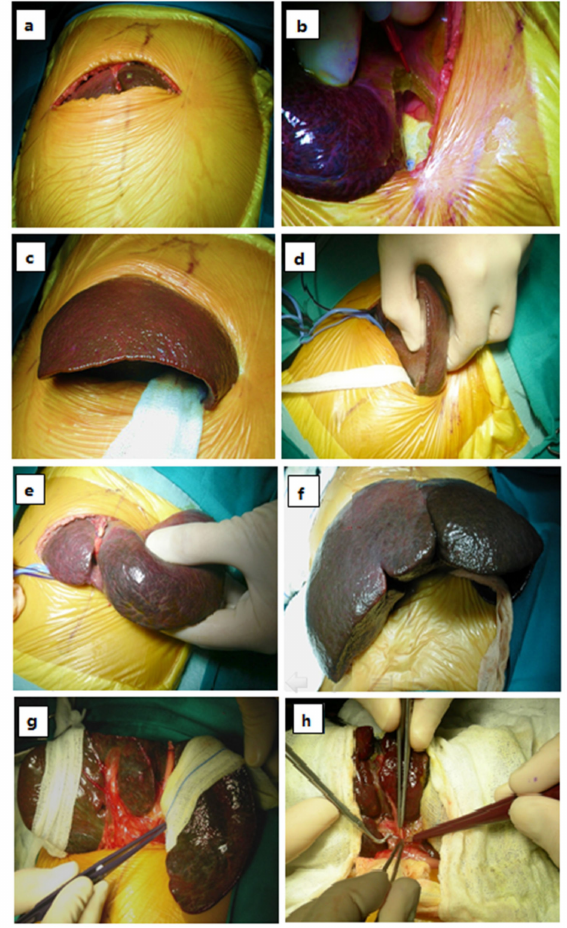
Figure 1. Laparotomy and ligation and division of the round ligament of the liver ( a ). Insertion of gauze between the left triangular and left coronary ligaments and the stomach and spleen. ( b ) The left lobe is gently grasped ( c ), is then gently rotated back to front ( d ) and is eventually pulled toward the left until achieving complete eversion ( e ). Complete eversion of the entire liver outside the laparotomy incision is accomplished by gently grasping the right lobe, which is pulled toward the left without section of the right ligaments ( f ). A swab is then placed in the hepatic loggia and two other gauzes, surrounding the left and right lobes, are cranially grasped to the drapes. At this point the liver is completely dislocated towards the outside, with the two gauzes keeping the liver well-everted, thus providing excellent exposure of the porta hepatis ( g ). The liver is then covered by two ribbon gauze soaked in saline solution to humidify the organ and to avoid air exposure in order to